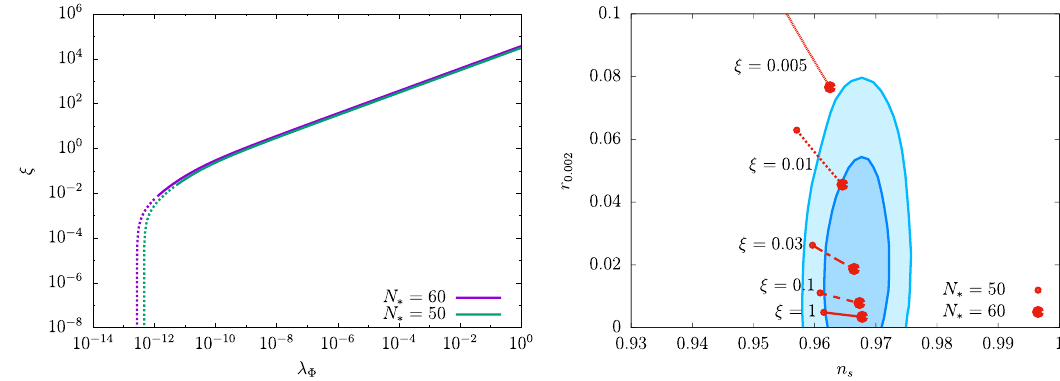
Figure 4 . Left: contours in the ( ξ , λ Φ ) plane for successful inflation where N ∗ is fixed as N ∗ = 50 and 60 . Right: predictions for the spectral index ( n ) and the tensor-to-scalar ratio ( r ) where the s non-minimal coupling ξ is taken as ξ = 1 , 0 . 1 , 0 . 03 , 0 . 01 and 0 . 005 . The blue and light blue regions are allowed by the PLANCK observation at 1 σ and 2 σ confidence level,